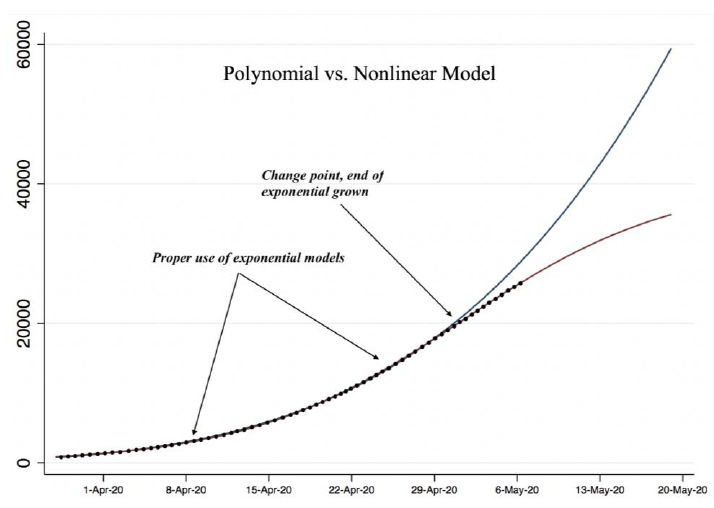
Figure 3. Polynomial versus a nonlinear growth model.